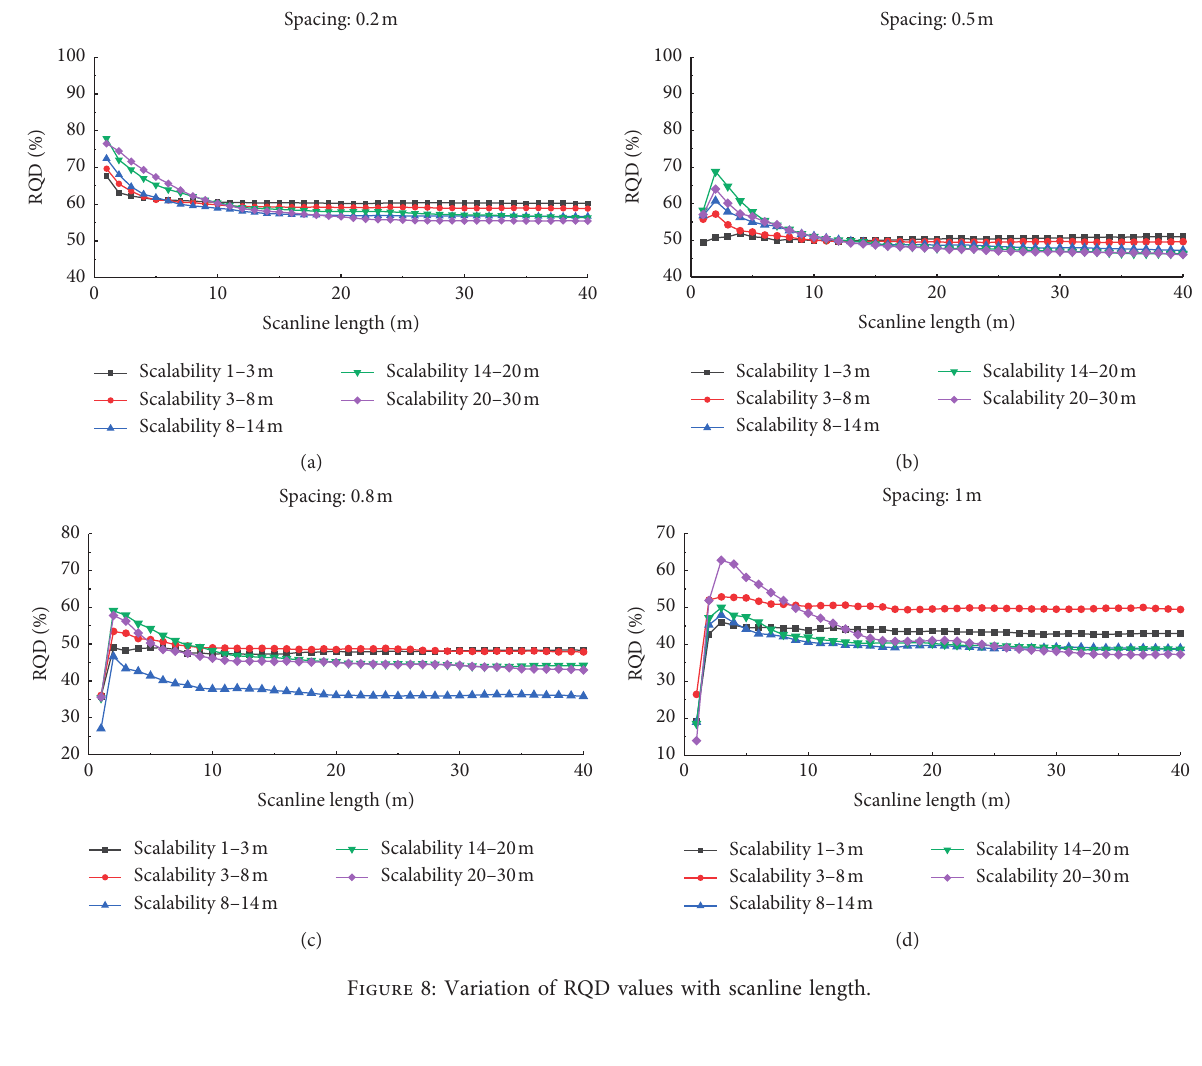
Figure 8: Variation of RQD values with scanline length.